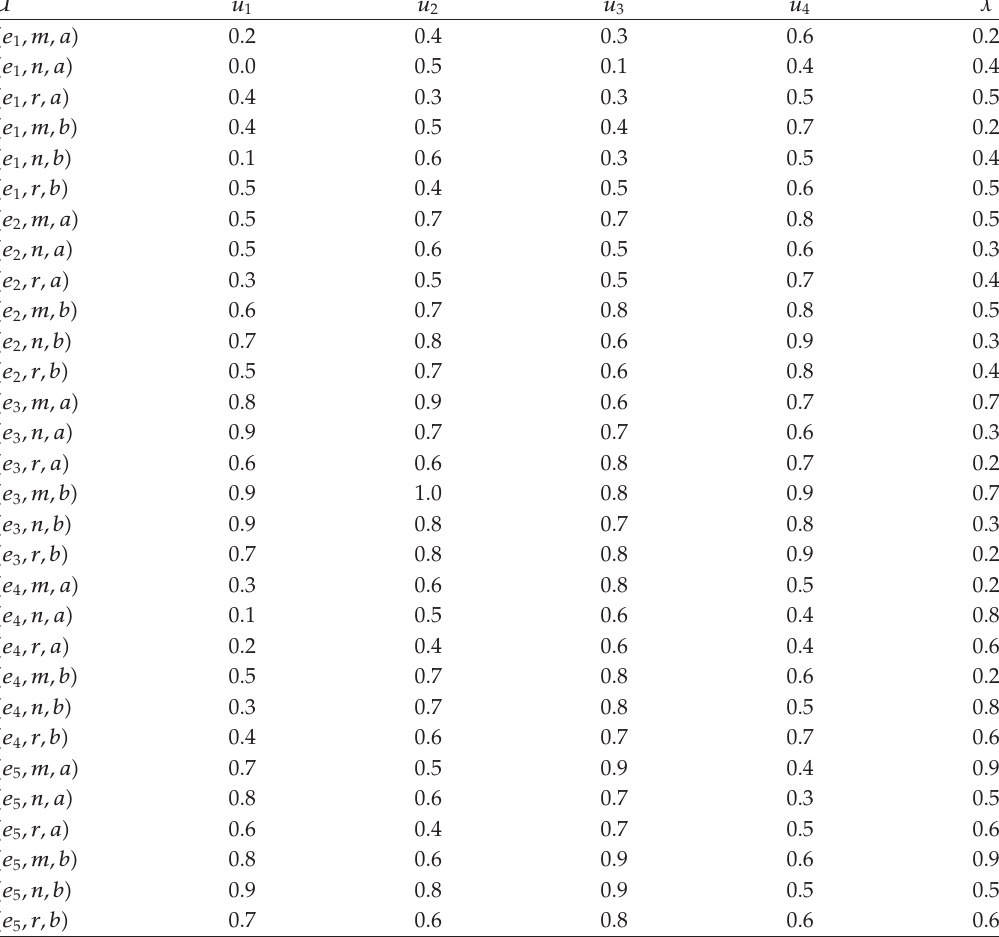
Table 5: Accepted opinions of generalized fuzzy soft expert